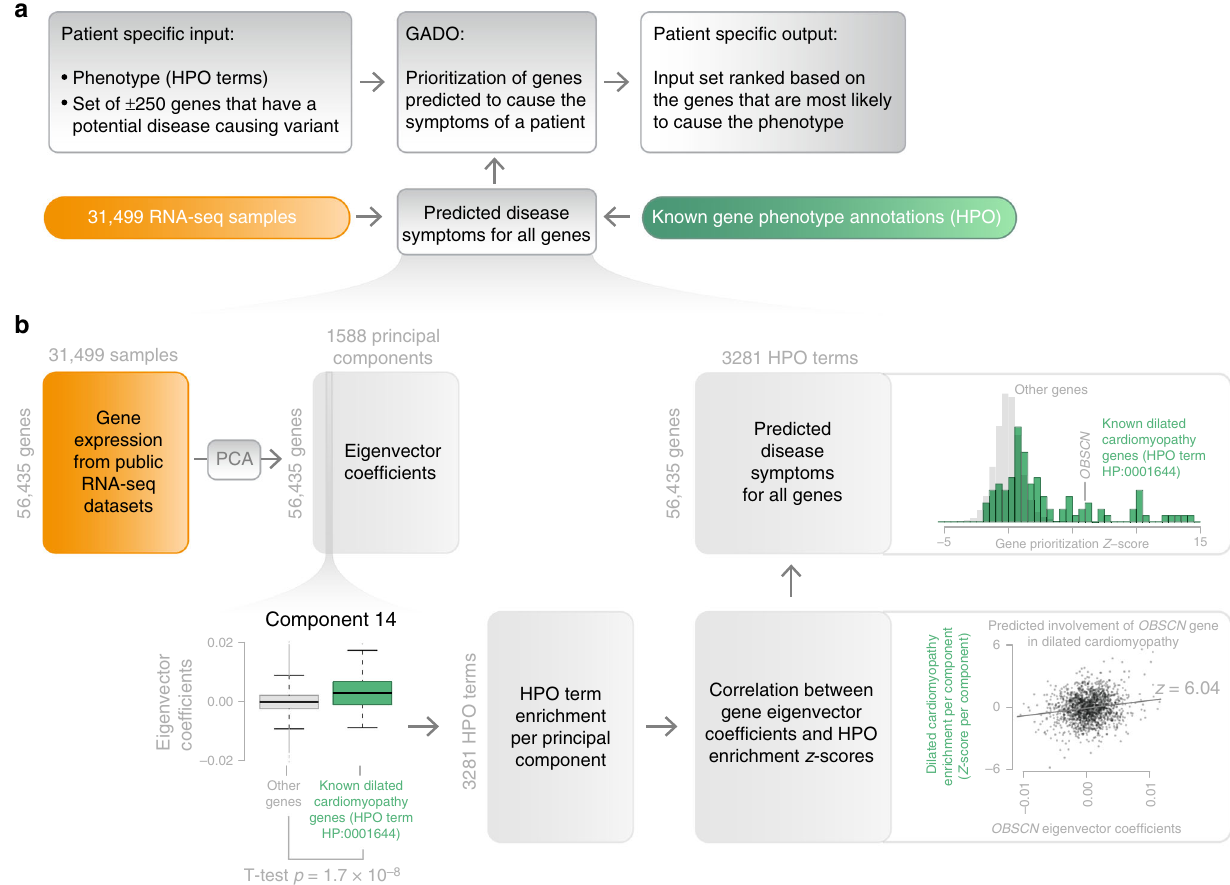
Fig. 1 Schematic overview of GADO. a Per patient, GADO requires a set of phenotypic features (encoded using HPO terms) and a list of candidate genes (gene names either entered using HGNC symbols or Ensembl IDs). This gene list should contain genes in which rare variants have been observed for the patient. It then ascertains whether any of these genes have been predicted to cause the phenotypic features, observed in the patient. These HPO phenotypes predictions per gene are based on observed co-regulation with sets of genes that are already known to be associated with these phenotypes. b Overview of how disease symptoms are predicted using gene expression data from 31,499 human RNA-seq samples. A principal component analysis on the co-expression matrix results in the identi fi cation of 1588 signi fi cant principal components. For each HPO term we investigate every component: per component we test whether there is a signi fi cant difference between eigenvector coef fi cients of genes known to cause a speci fi c phenotype and a background set of genes. This results in a matrix that indicates which principal components are informative for every HPO term. By correlating this matrix to the eigenvector coef fi cients of every individual gene, it is possible to infer the likely HPO disease phenotype term that would be the result of